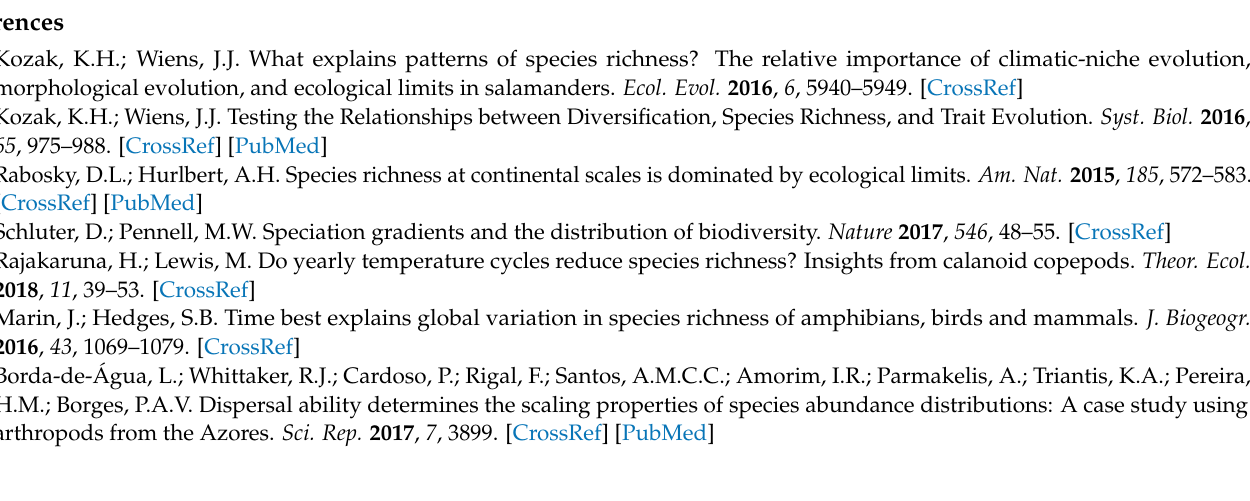
comparison results, Table S3: BioGeoBEARS stochastic mapping results, Supplementary Animation S1. Note S1: ABGD analyses results, Figure S1: unconstrained all-terminal COI Tetragnatha phylogeny and Figure S2: detailed results of bModelTest model